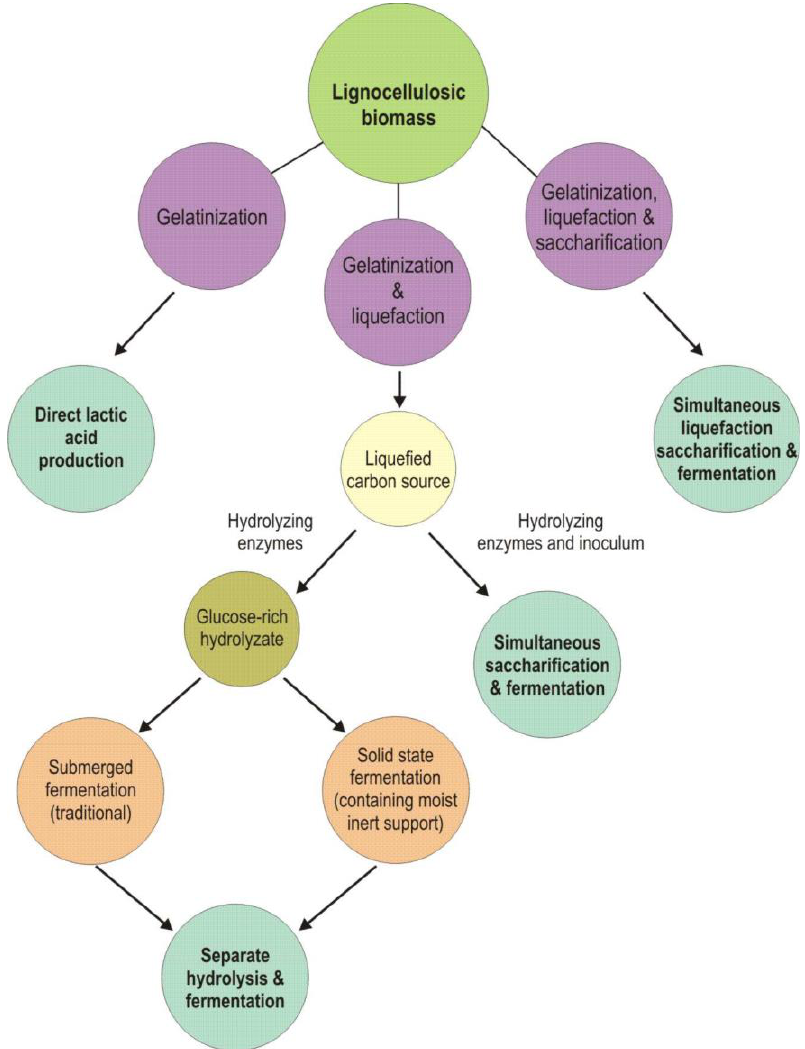
Figure 8. Processes in the production of lactic acid from lignocellulosic biomass (Adapted from John et al. (2007) [11]).